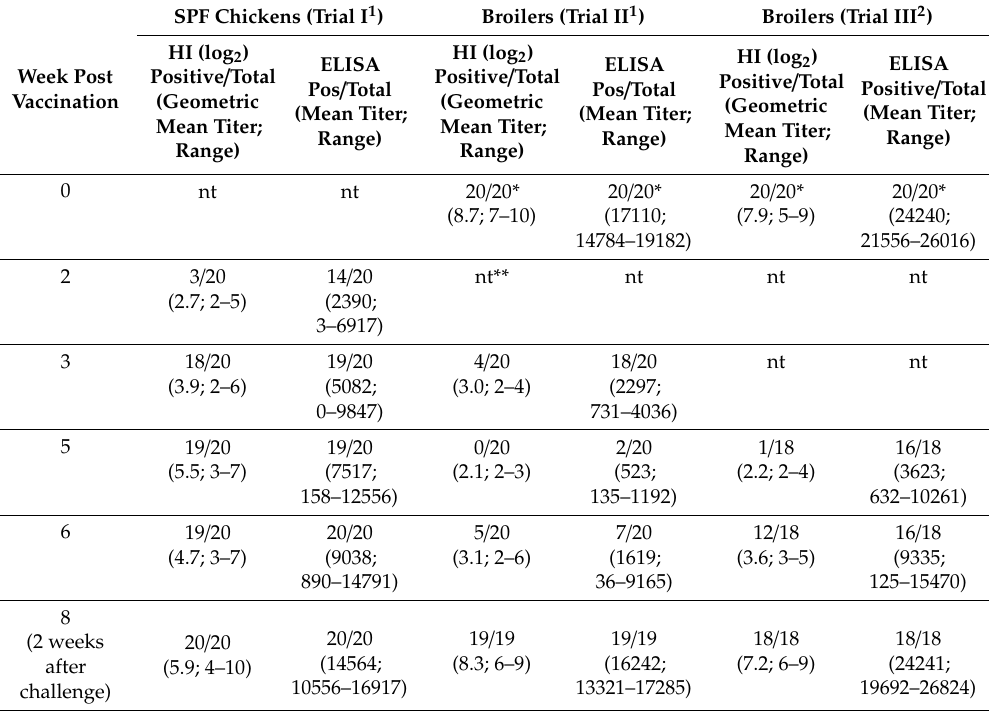
Table 2. The results of serological examination of sera collected from SPF and broiler chickens immunized with the HVT-NDV-F-HN vaccine